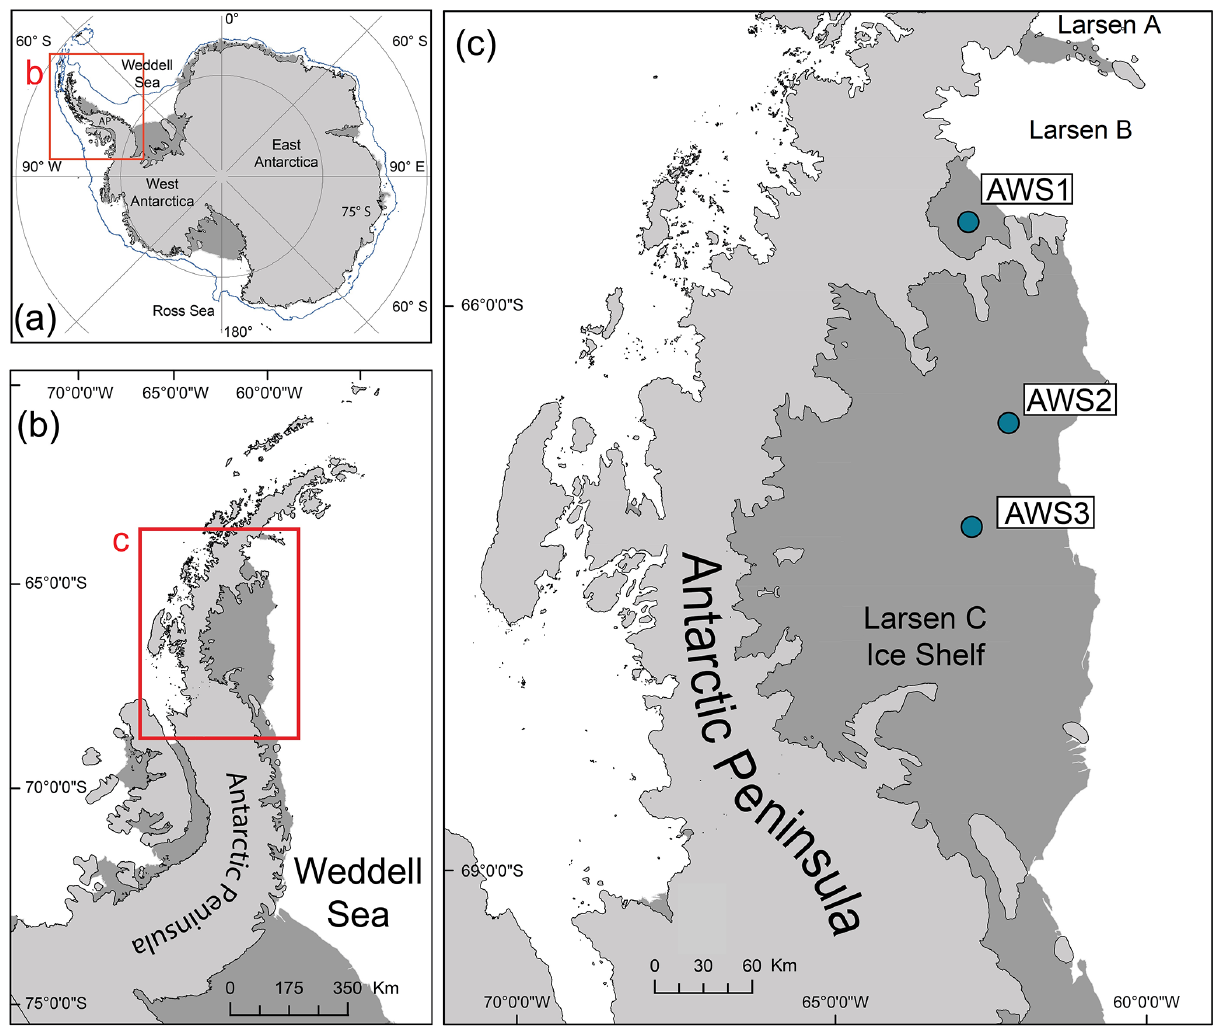
Figure 1. (a) A map of the Antarctic continent, with a blue line showing the average sea ice extent and a red box outlining the area in (b) . (b) A map of the Antarctic Peninsula (light grey) and ice shelves (dark grey), with a red box indicating the area shown in (c) . (c) A map of the Larsen C Ice Shelf with the three AWS locations marked with blue dots. Coastlines and sea ice extent are imported from the Antarctic Digital Database. This figure is adapted from Turton et al.